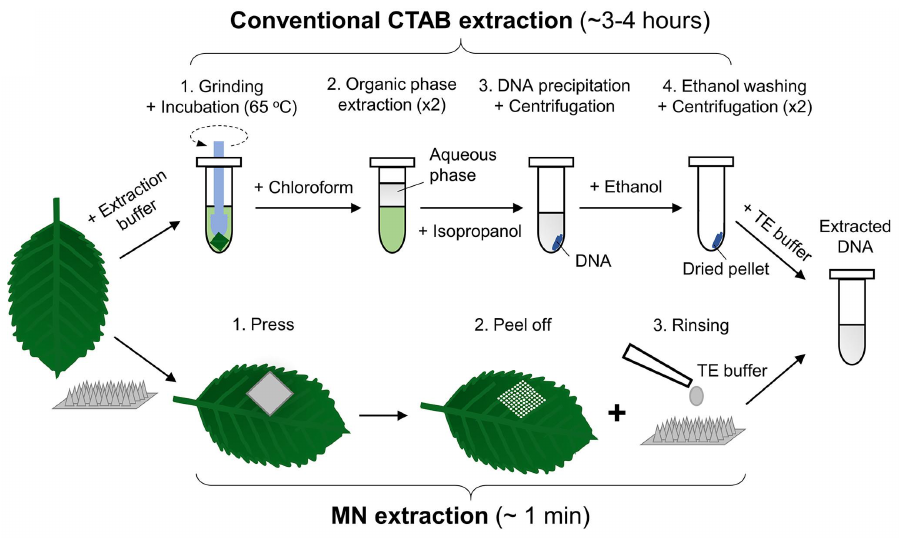
Figure 4. DNA extraction procedures for nucleic acid-based methods, a comparison between conven- tional method (cetyltrimethylammonium bromide; CTAB) and a micro-needle (MN)-based approach. Reprinted with permission from [56]. Copyright (2019) American Chemical